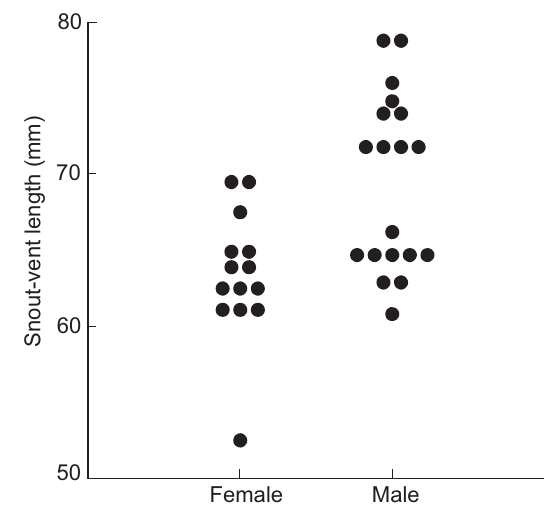
Figure 1. Snout-vent length (mm) of adult males and females of C. ocellifer from the Morro do Chapéu, Bahia.